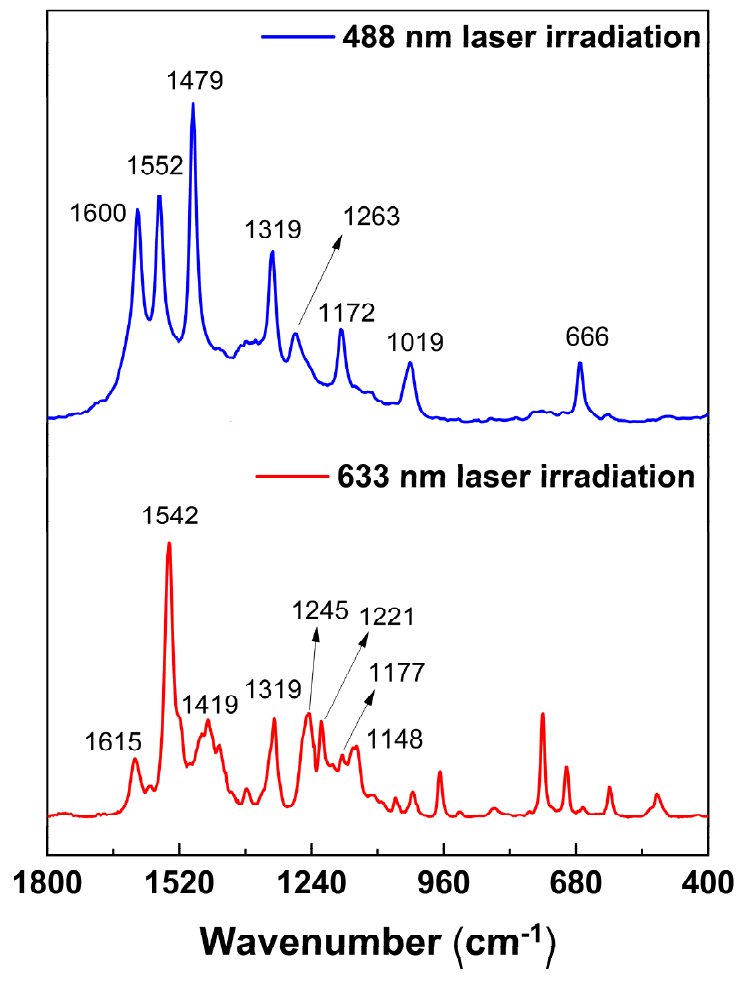
Figure 5. Raman spectra of the supramolecular tetraruthenated complex TRuCoTPyPz. The [Ru(bpy) 2 Cl] + vibrational modes are observed when the sample is irradiated at 488 nm laser (blue line), while the central CoTPyPz vibrational bands are intensified with laser irradiation at 633 nm (red line).